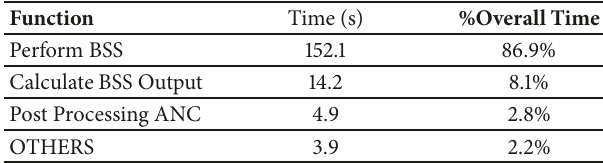
Table 1: Profiling results of overall operations.